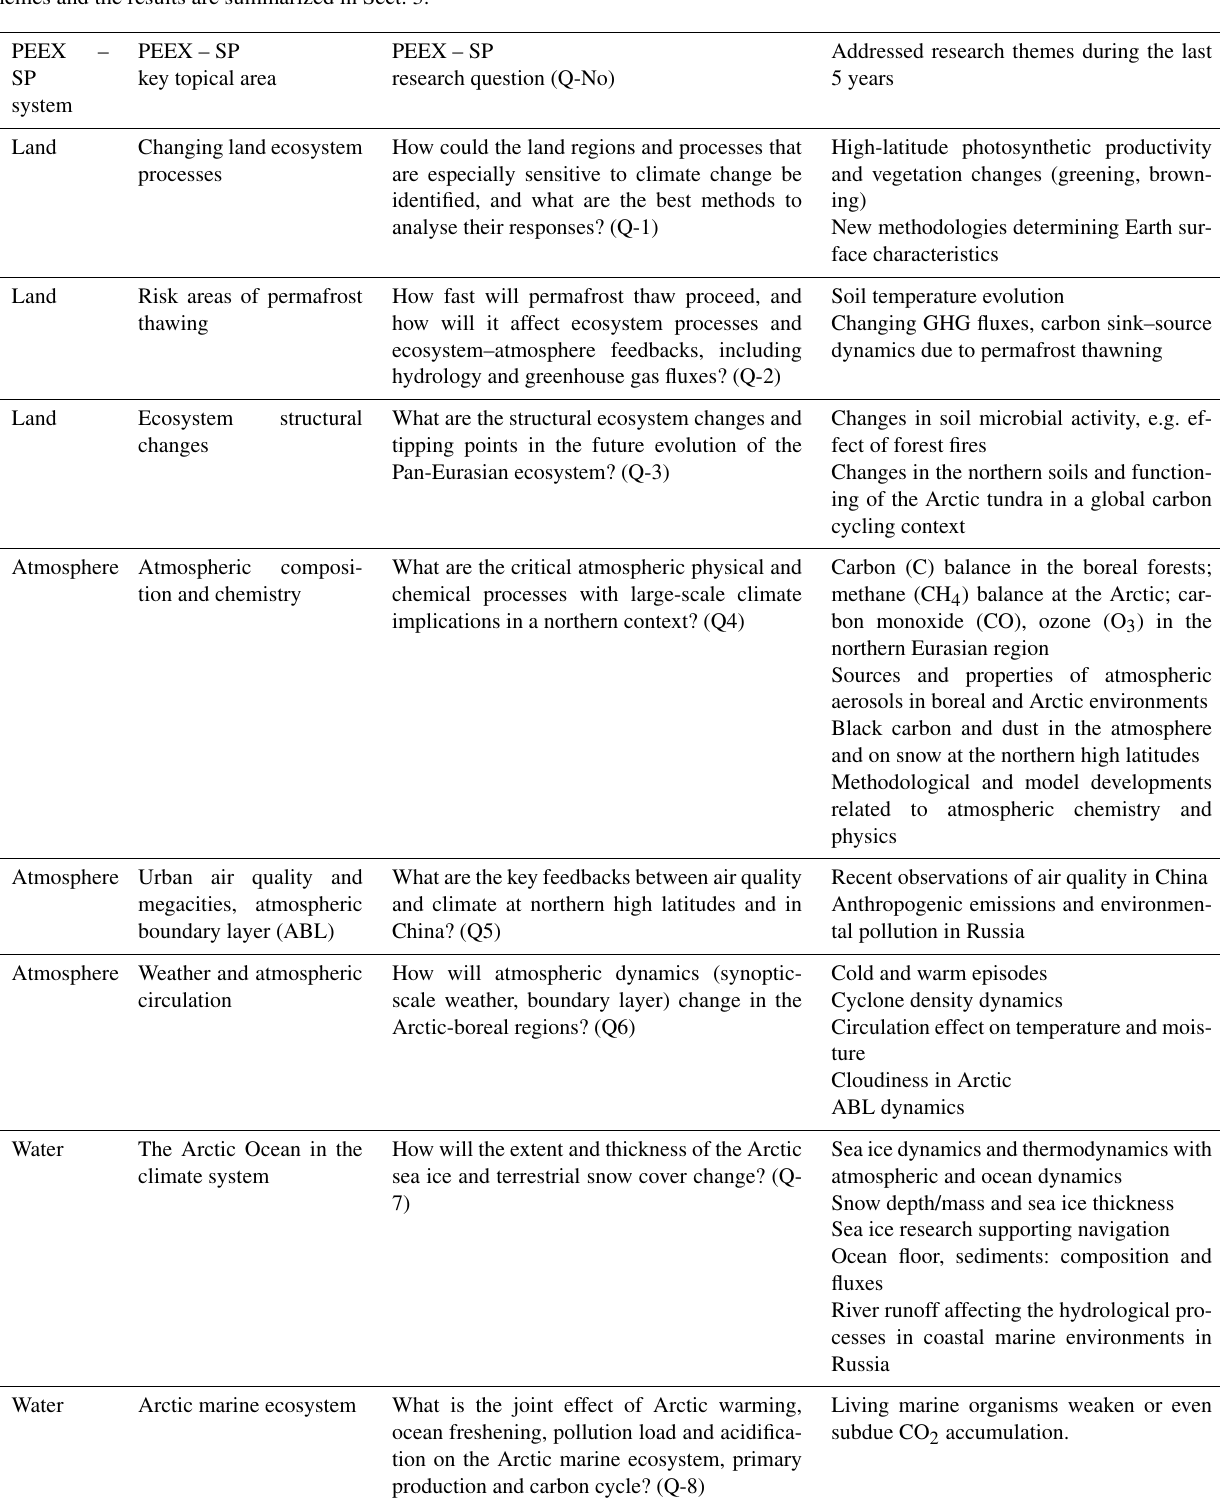
Table 1. Systems, key topical areas, and research question introduced in the PEEX Science Plan (SP) (Kulmala et al., 2015, 2016a; Lap- palainen et al., 2018a) connected to the addressed research themes over the last 5 years by the PEEX questionnaire. The addressed research themes and the results are summarized in Sect.